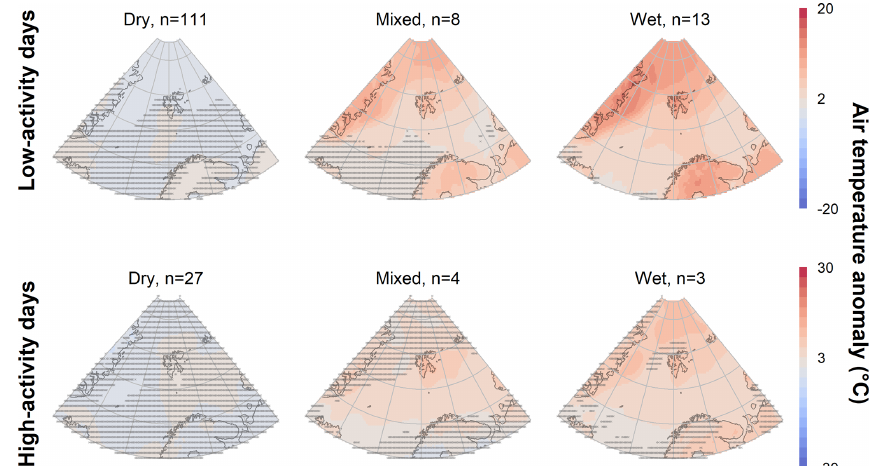
Figure C1. Daily mean air temperature anomalies, relative to mean winter conditions (Fig. B1), for dry, mixed, and wet avalanche low- and high-activity days. Anomalies that are not significantly statistically different from mean winter conditions are indicated with dense hatching.